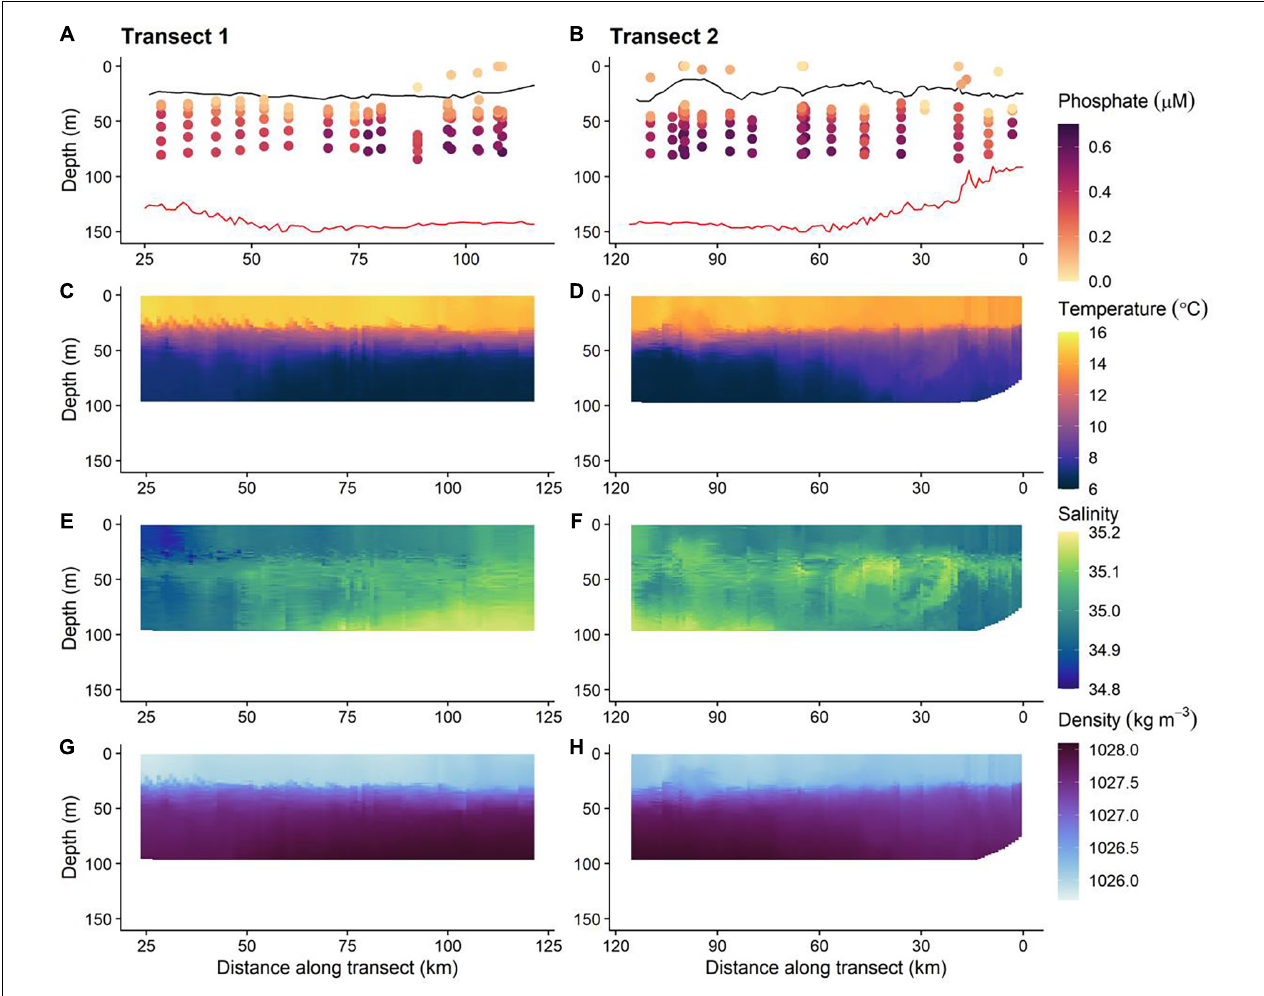
FIGURE 7 | The physical and biogeochemical in situ glider dataset; 0 km is the start transect 1 and the end of transect 2 (i.e., time runs left to right along the horizontal axis). Red and black lines on phosphate plots (A,B) are the GEBCO bathymetry and thermocline, respectively. The location of the thermocline is defined as a 0.03 kg m − 3 density increase relative to that at 10 m depth (de Boyer Montégut et al., 2004). (C,D) Temperature, (E,F) salinity, and (G,H) density.